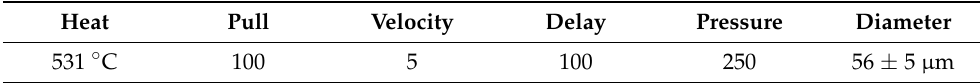
Figure 2. The production process of the glass nozzle with the micropipette puller. Table 1. Micropipette puller setup